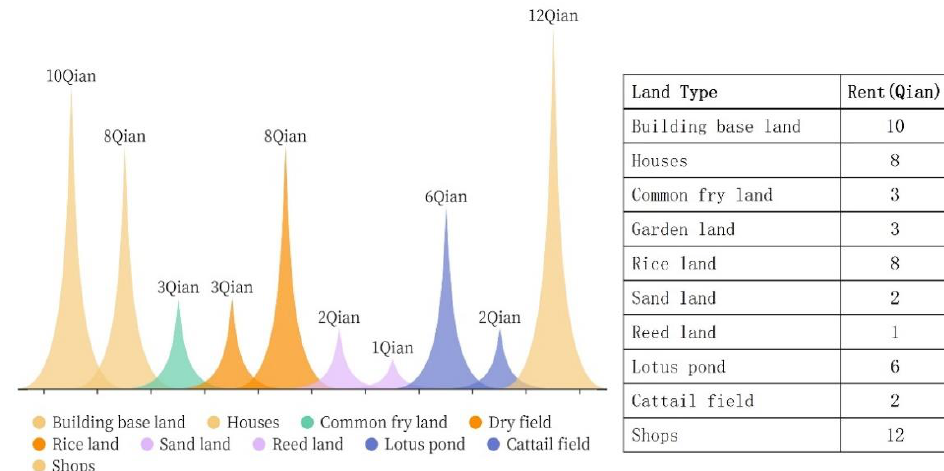
Figure 18. Comparative chart of rent per mu (per house) of levied land.